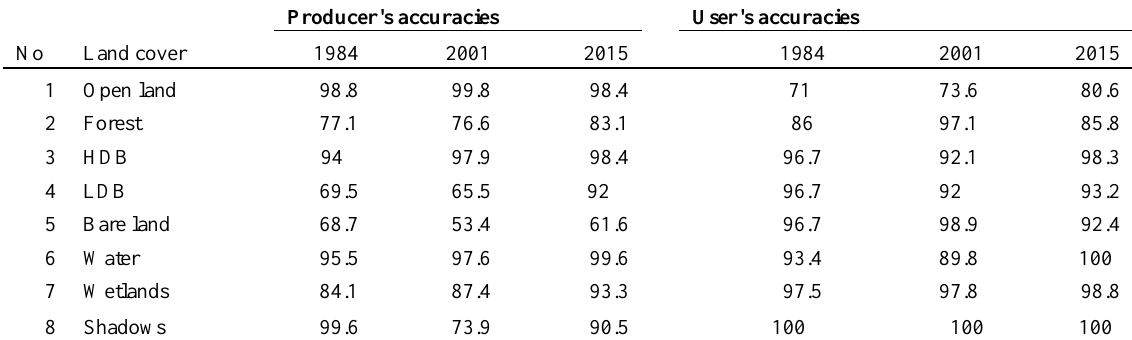
Table 3: Producer’s and user’s accuracies (in